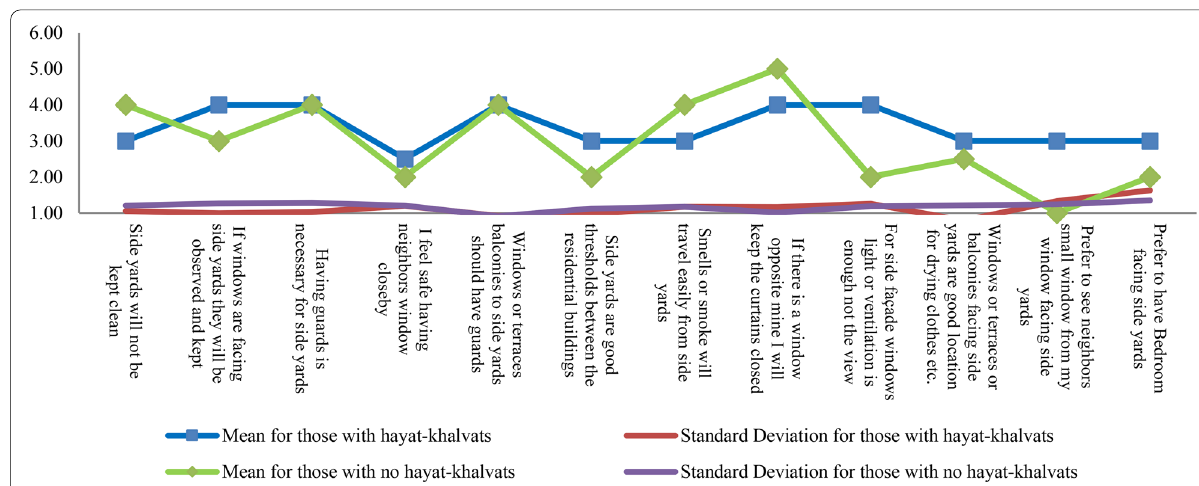
Fig. 4 Significant items after Multivariate ANOVA on the data from those with hayat-khalvats and those with no